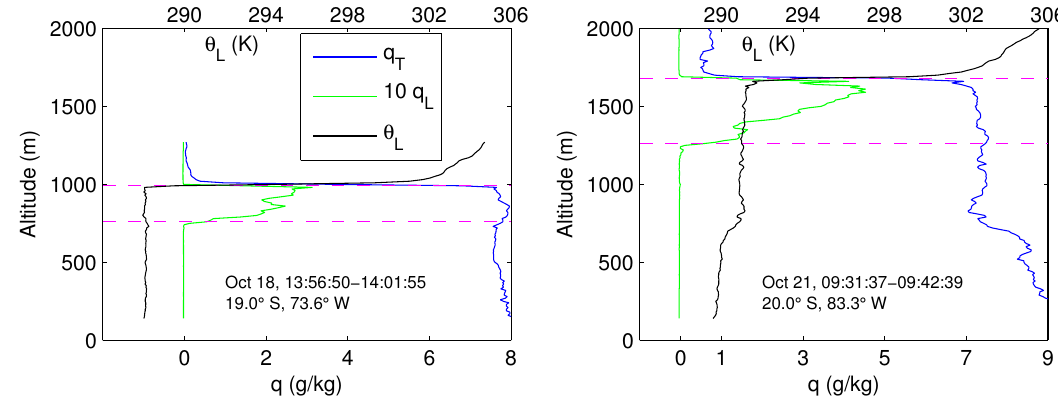
Fig. 2. Typical well-mixed (left) and decoupled (right) profiles of moist-conserved variables. For ease of viewing, 10 times q ‘ is plotted in green. The dashed magenta lines demarcate the cloud